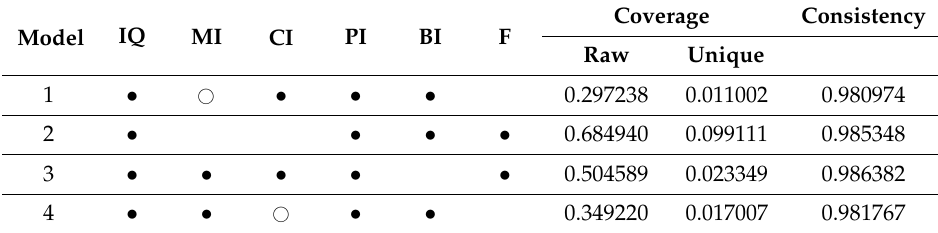
Solution coverage: 0.738747; Solution consistency: